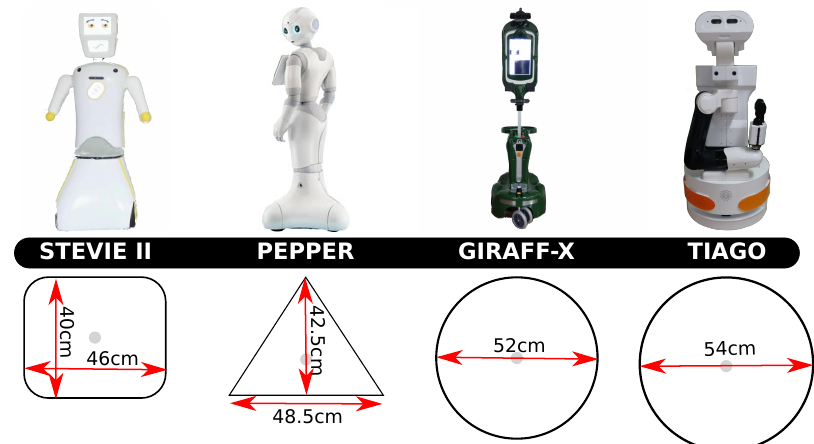
Figure 5. Pictures of the four robots considered in the experimental section together with their respective footprints. The robots have been ordered according to the dimensions of their footprints from left (smallest) to right